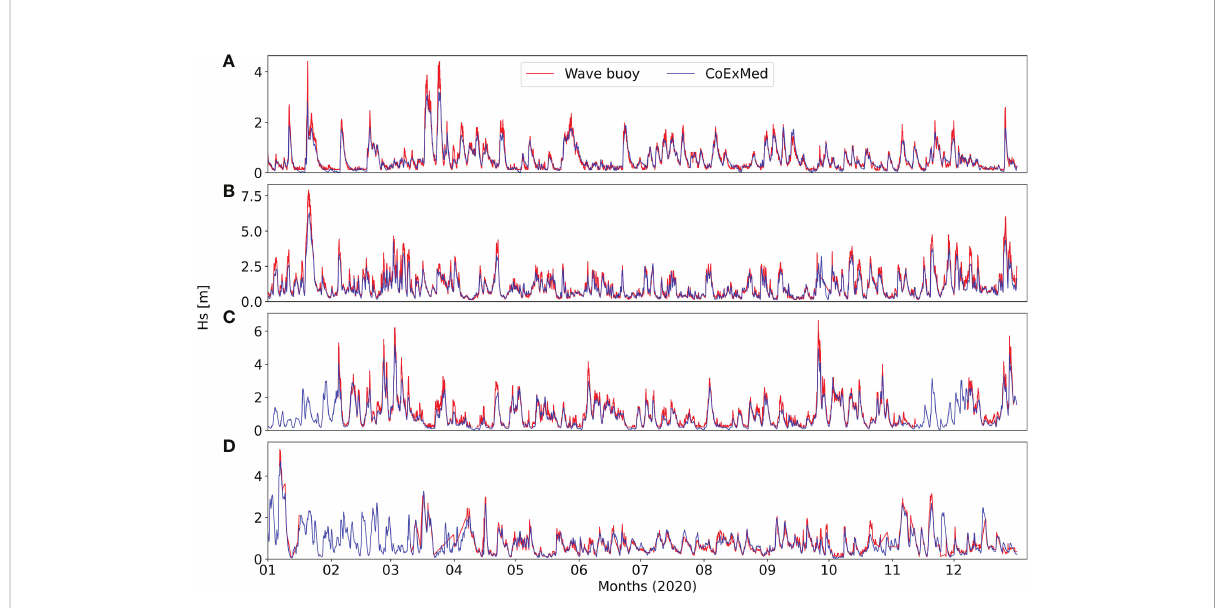
FIGURE 6 H S time series of wave buoys (black lines) and simulated H S at four different location: Melilla ( A , -2.944E/35.327N), Begur ( B , 3.64E/41.92N), Calvi ( C , 8.65E/42.569N) and Heraklion ( D ,